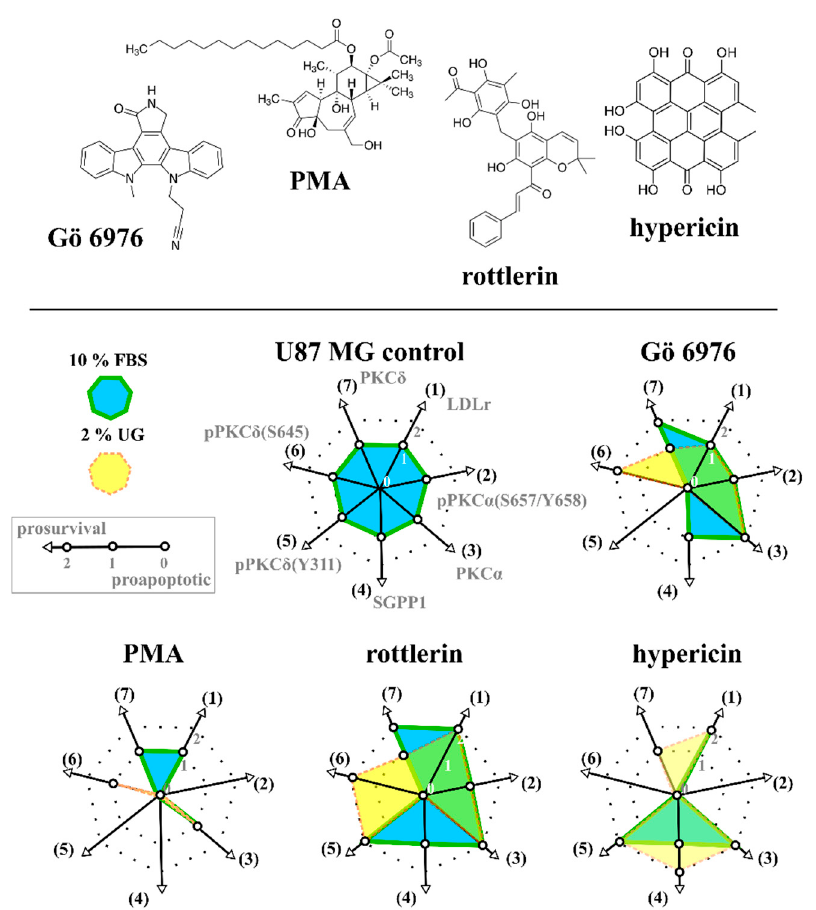
Figure 1. Chemical structures of Gö 6976, PMA, rottlerin, and hypericin (top row). Spider diagram showing the parameters obtained by the evaluation procedure from the parameters in Table 2 in the presence (blue) and absence of lipids (yellow); the overlap is green. LDLr—increase in LDL receptors, pPKC α (S657/Y658)—phosphorylation of PKC α catalytic domain, PKC α —increase in PKC α , SGPP1—increase in sphingosine-1-phosphatase, pPKC δ (Y311)—phosphorylation of PKC δ regulatory domain, pPKC δ (S645)—phosphorylation of PKC δ catalytic domain, and PKC δ —increase in PKC δ .